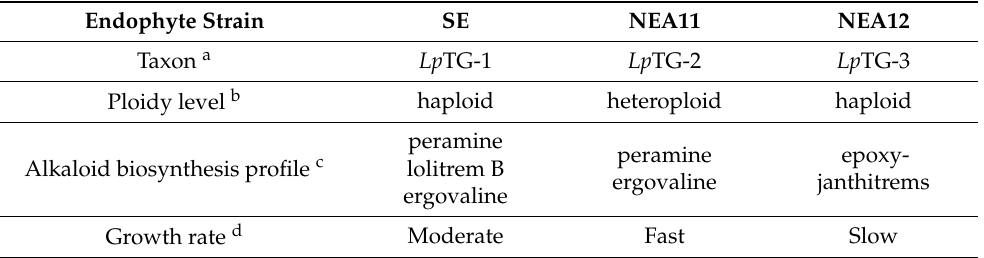
Table 1. Properties of selected asexual Epichloë endophytes used in transcriptome analysis of symbioses.